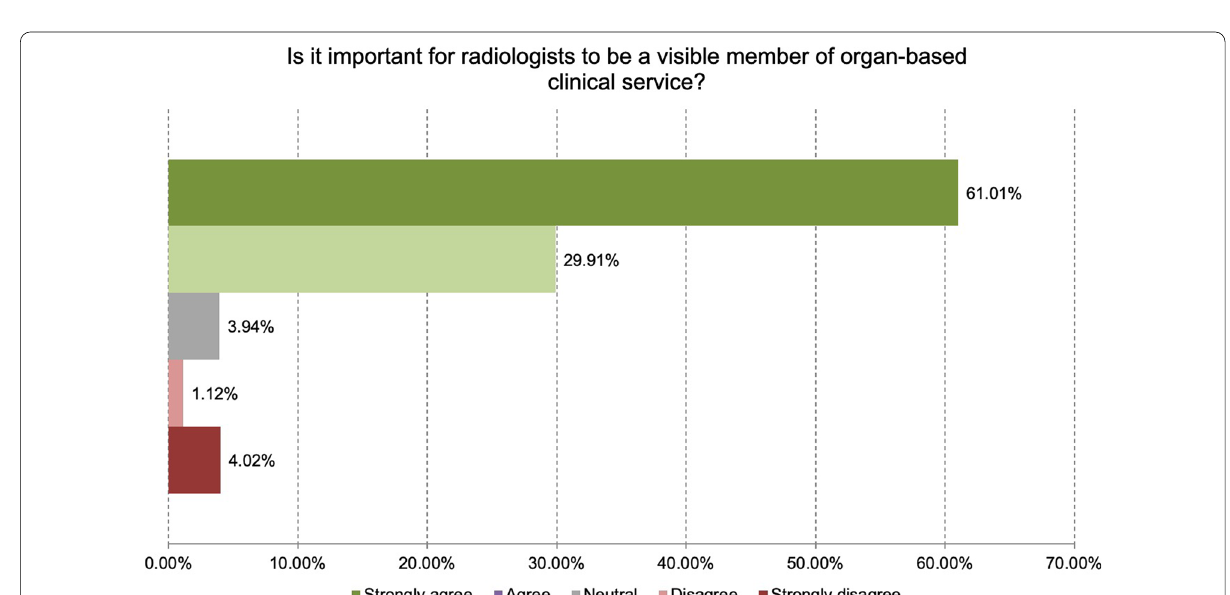
Fig. 6 In your opinion, is visibility important for our identity in the clinical service e.g. is it important for radiologists to be a visible member of organ-based clinical service? (responses n =